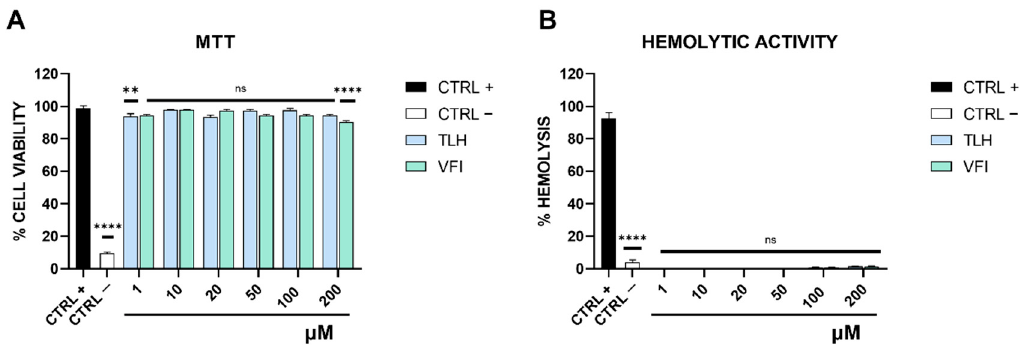
Figure 1. Tripeptides toxicity in vitro cultures ( A ) and human erythrocytes ( B ). CTRL+ refers to positive control (untreated cells for MTT assay, and Triton X-100 20% for the hemolysis test) and CTRL— indicates the negative control (DMSO-treated cells for MTT assay, and PBS-treated cells for the hemolysis test); **** p ≤ 0.0001; ** p ≤ 0.01; ns: non-significant.